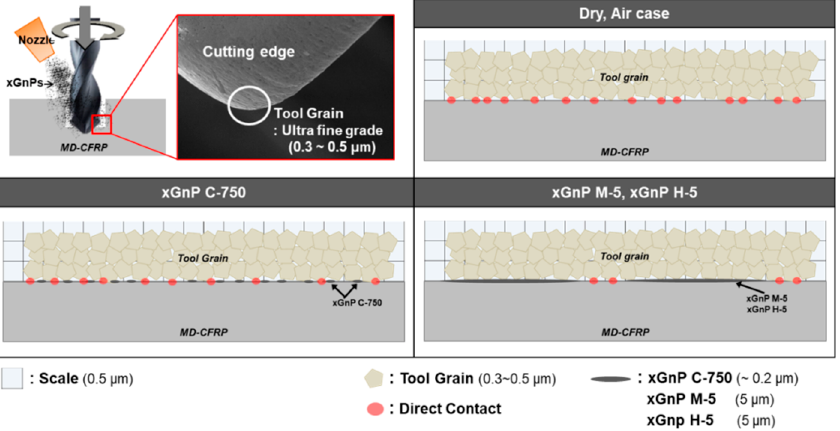
Figure 19. Lubrication mechanism of micro-drilling of MD-CFRP using nano-solid dry lubrication according to the average particle size (APS) of graphene nanoplatelets